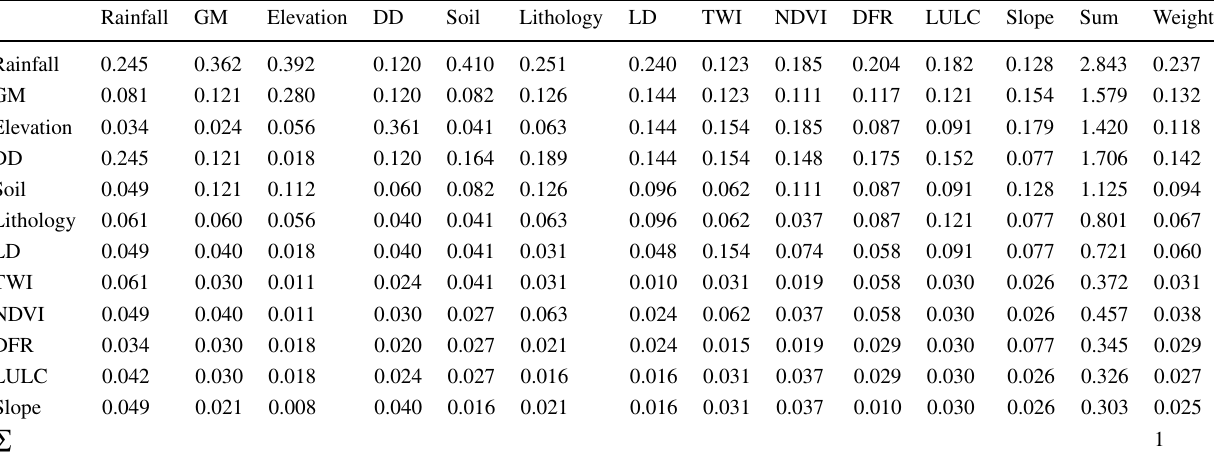
Table 5 Normalized pairwise comparison matrix Rainfall